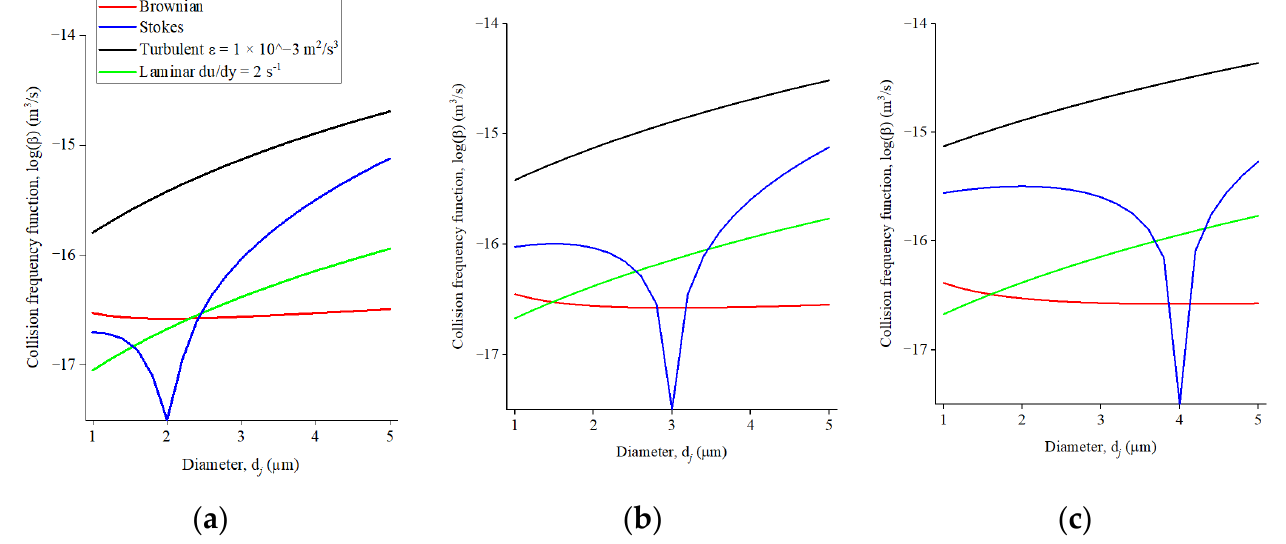
Figure 15. Comparison of collision frequency function for Brownian motion, Stokes motion, and laminar and turbulent flow for an inclusion with a diameter d i of ( a ) 2 µ m, ( b ) 3 µ m, ( c ) 4 µ m and varied d j